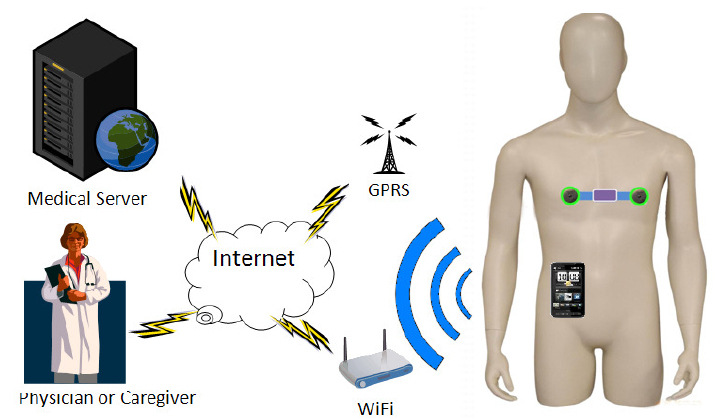
Figure 1. The architecture of